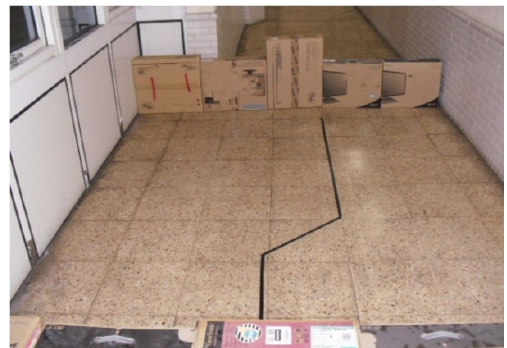
Figure 25. Testing field of indoor patrol.